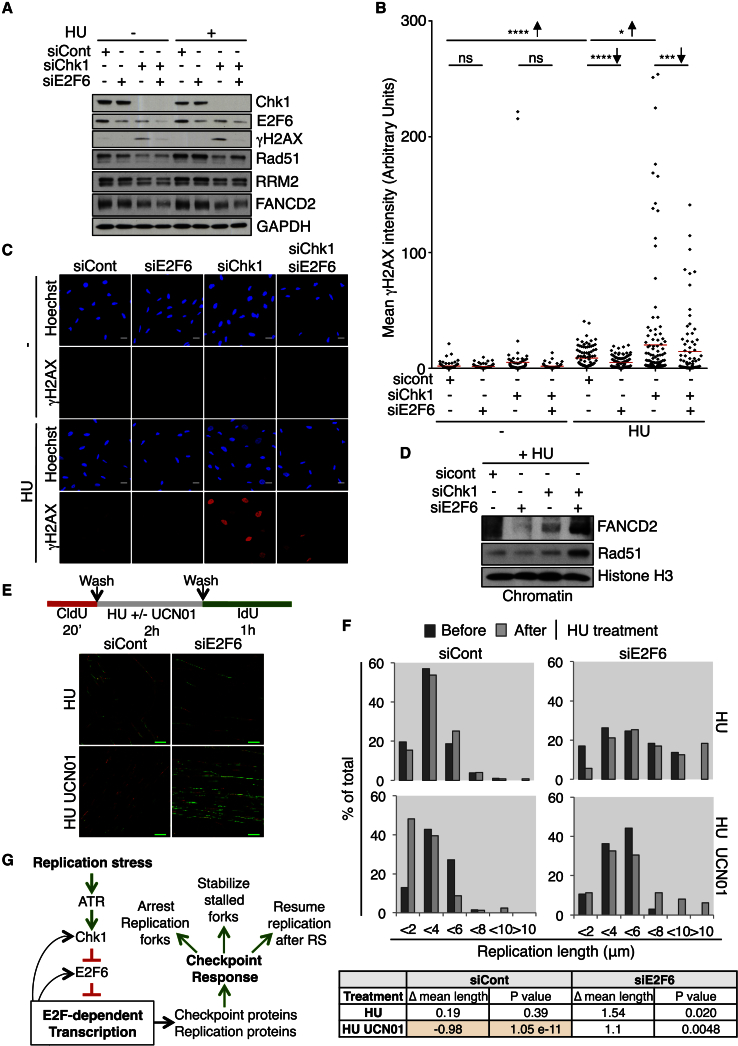
E2F Activity Is Sufficient to Prevent DNA Damage and Rescue Checkpoint Functions in Cells with a Compromised Checkpoint Response(A) Western blot of WCE, RPE1 cells transfected with siRNA shown −/+ 4 hr HU,.(B) Column scatter graph of mean intensity of γH2AX of individual nuclei, RPE1 cells from 4A. Transfected with siRNA are shown −/+ 4 hr HU. Mean is in red. ∗∗∗∗p < 0.0001; ∗∗∗p < 0.001; ∗p < 0.05 with Wilcoxon. Arrows show change of mean.(C) Representative images for (B). The scale bar represents 20 μm and is the same for all.(D) Western blot of chromatin preparation, RPE1 cells transfected with siRNA shown, HU 4 hr.(E) Schematic and representative images for (F), T98G cells. The scale bar represents 10 μm.(F) Bar graphs of length of DNA tracks before and after HU treatment with siRNA and treatments shown. Table is of differences in mean length (after-before). p, difference with Wilcoxon.(G) RS checkpoint activation sustains E2F transcription. This transcriptional response is essential and sufficient during RS to maintain optimal protein levels and important functions of the checkpoint response to prevent RS-induced DNA damage.See also Figures S4 and S5.